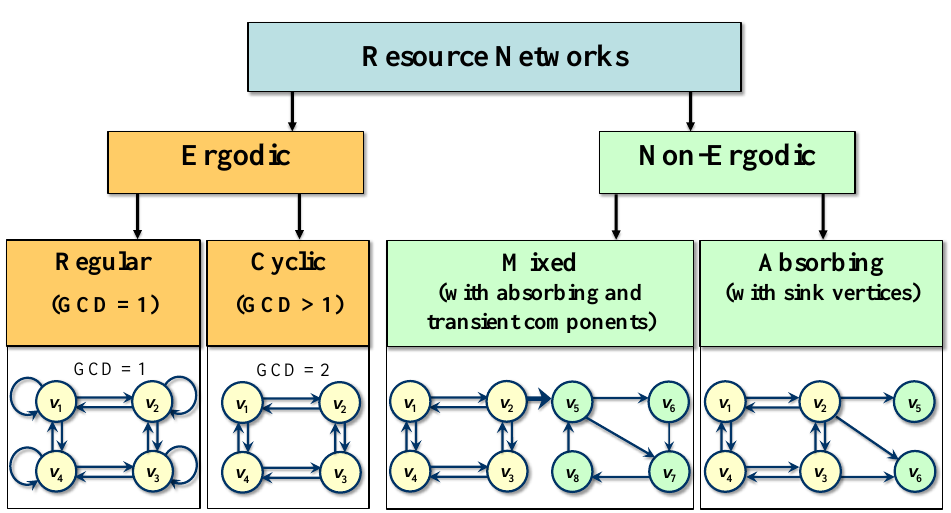
Figure 1. Classification of networks by